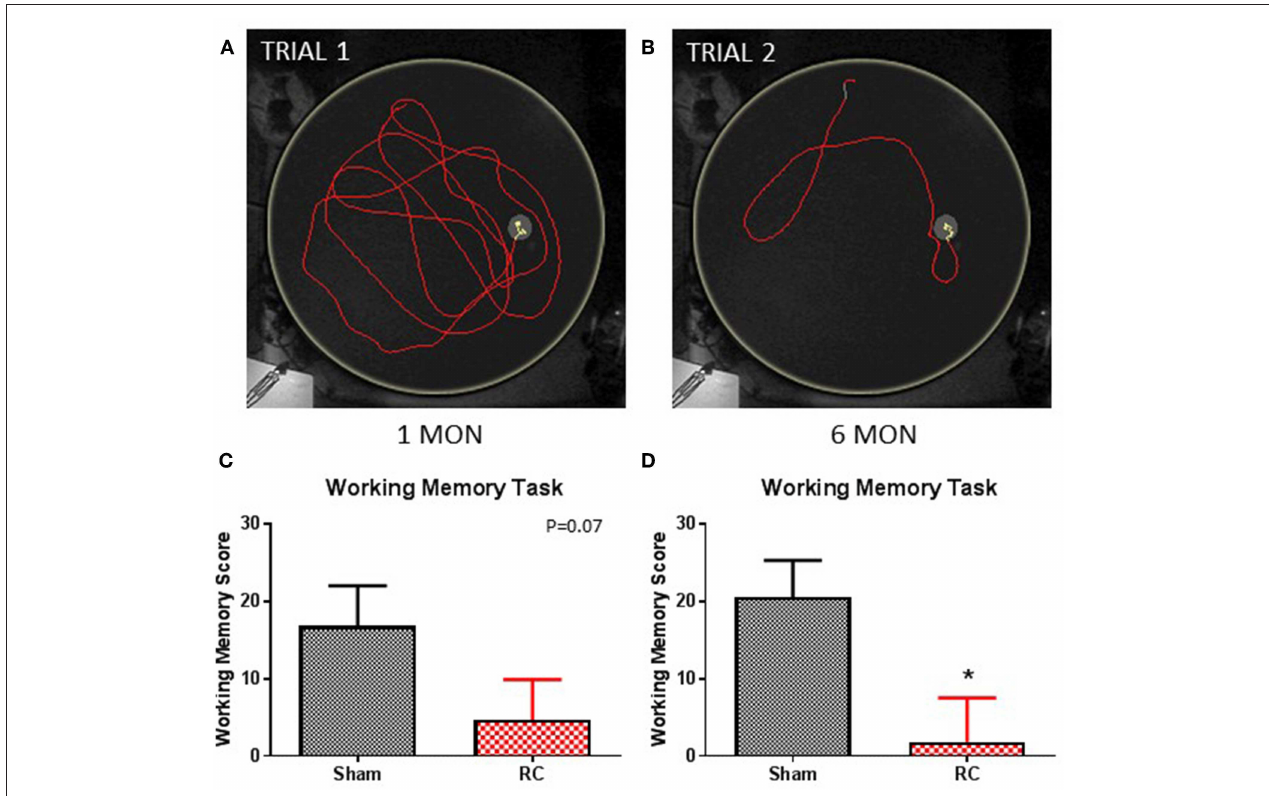
FIGURE 4 | Working memory task. Trace within the MWM tank (yellow circle) represents swimming to search for the hidden platform in a set of trials: trial 1 (A) and trial 2 (B) (yellow trace—platform; red trace—outside of platform) for a sham rat. At 1 month post-injury (C) , rats sustained repeated concussive impacts (RC) showed a trend toward worse performance, but this failed to reach statistical significance compared to sham controls on the working memory task (group n = 12; p = 0.07). At 6 months post-injury (D) , the concussed rats (RC) exhibited significantly worsened working memory performance compared to sham controls (group n = 12; * p <